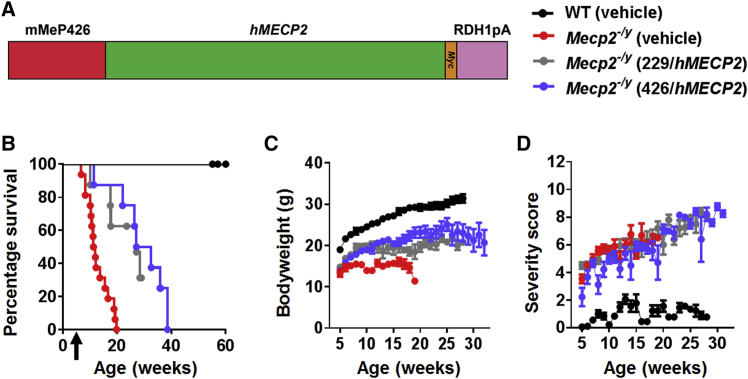
Therapeutic Efficacy of Second-Generation Vector after Systemic Delivery to Mecp2−/y Mice(A) Design features of our second-generation vector summarized (see Results and Figure S7 for details). (B) Survival plot for Mecp2−/y mice treated intravenously with 1 × 1012 vg per mouse of the second-generation vector (median survival = 29.9 weeks) or an identical dose of first-generation vector (median survival = 27.1 weeks) or vehicle (median survival = 11.6 weeks). Arrow indicates age at injection. (C and D) Plots showing (C) mean body weight and (D) aggregate severity scores, respectively, of Mecp2−/y mice treated as in (B). See also Figure S7.